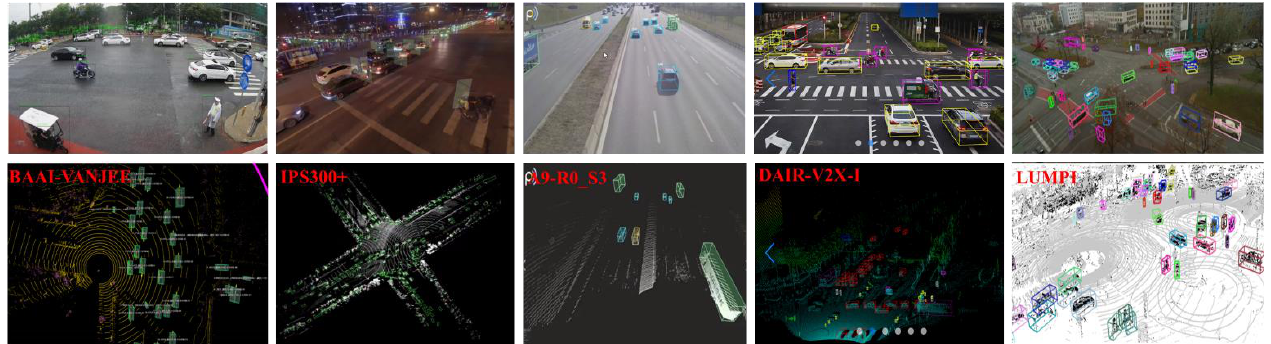
Figure 9. Dataset collected by roadside LiDAR and cameras.